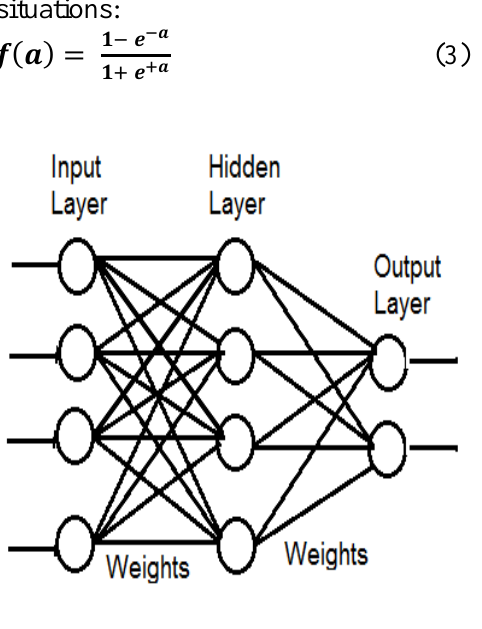
Fig. 2: Multilayer perceptron neural network [9].